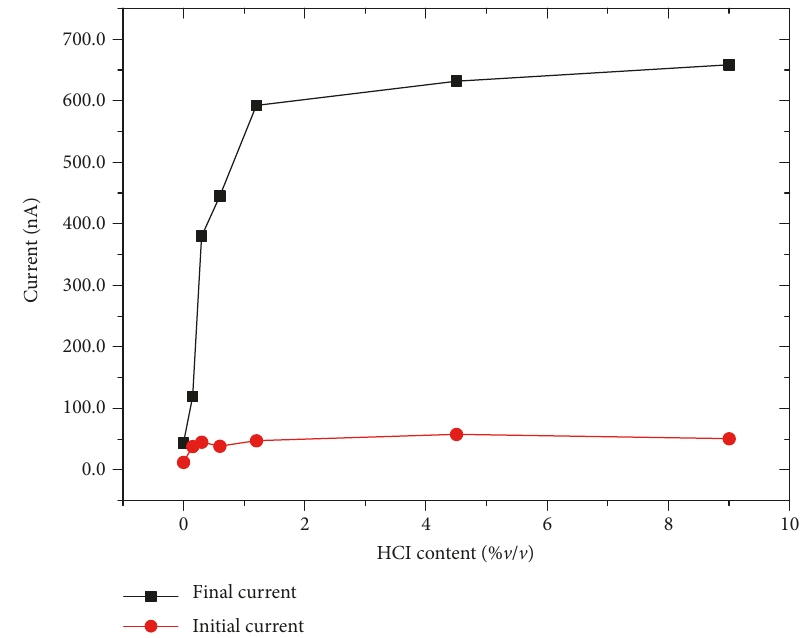
Figure 4: Final and initial current values of the Memristor ’ s responses reported in Figure 3 for a progressive lowering of chloride ion content in the polyelectrolyte.